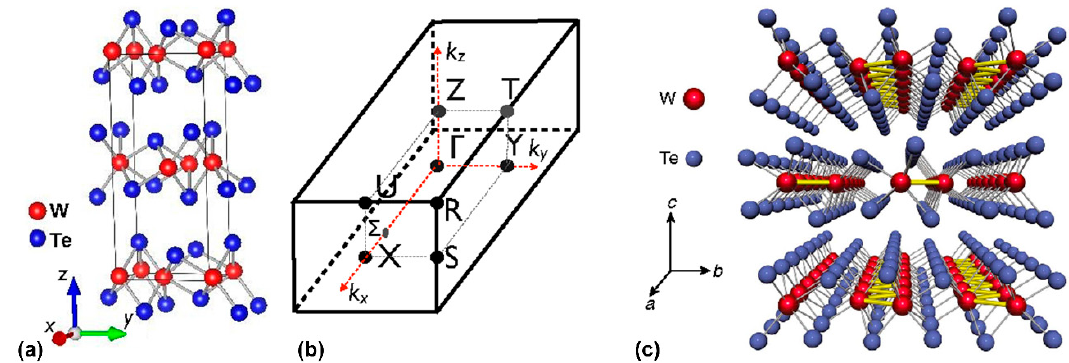
Figure 1. ( a ) The crystal structure of WTe 2 along the x-axis, y-axis, and z-axis; ( b ) The Brillouin zone of the rhombohedral unit cell [12]; ( c ) The crystal structure of WTe 2 in ab-plane and along c-axis [10].